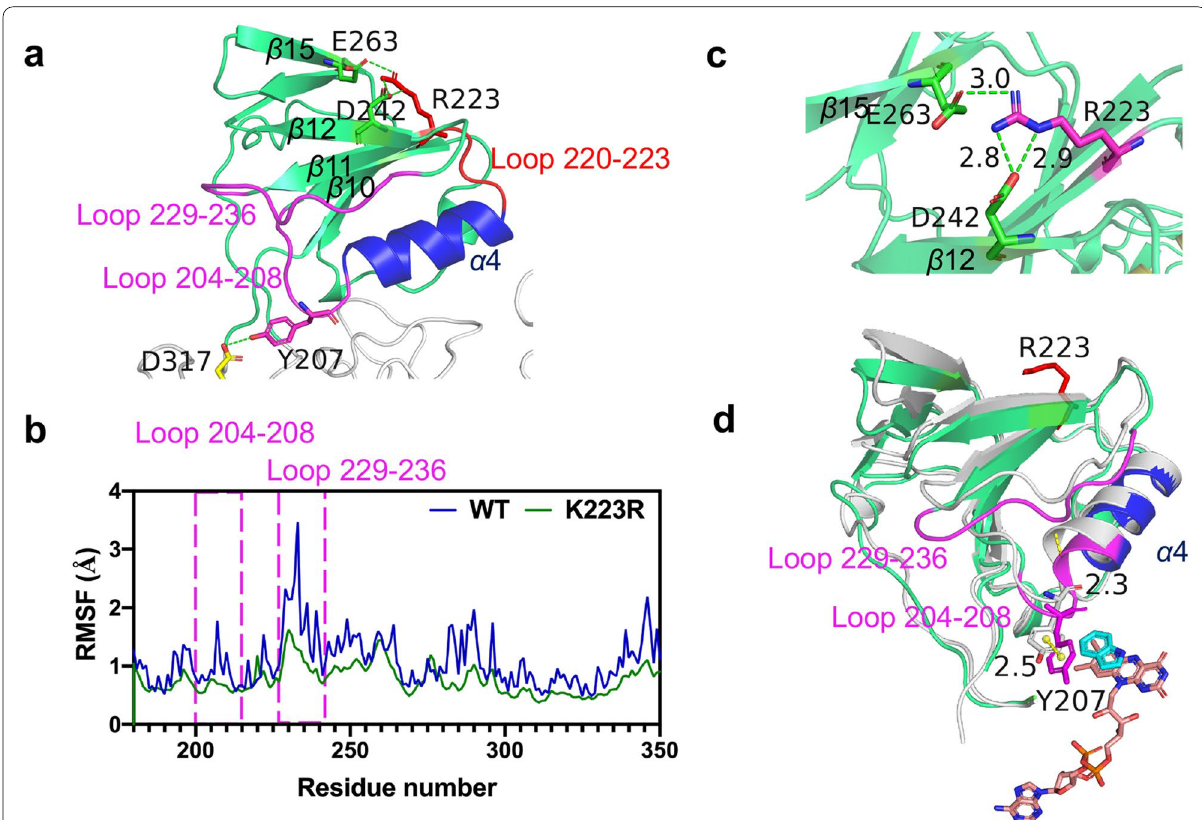
Fig. 5 a Illusration of the small domain (green) of K223R mutant, which shows the locations of the α4 helix (blue), the loop 229–236 (purple), the loop 204–208 (purple), and the loop 220–223 (red), were displayed in cartoon by PyMOL. b RMSF values of wild‑type bFMO (blue) and the K223R mutant (green). The RMSF of atomic positions was calculated according to a reference frame in the trajectory, and the RMSF of residues was calculated by averaging the RMSF of atoms of each residue. c New hydrogen bond (green dashed lines) generated between R223 with E263 and V200, respectively. R223 (purple), E263 (green) and V200 (green) were displayed as sticks. d Movement of α4 helix (blue) in the K223R mutant compared with that of the wild‑type bFMO (grey). The distance of the movement was indicated by yellow dashed